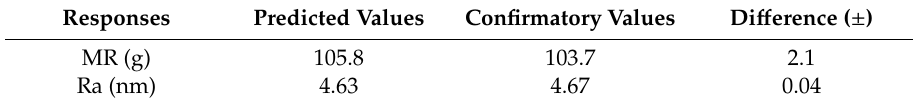
Table 6. Predicted and confirmatory experimentation results at optimized levels of input